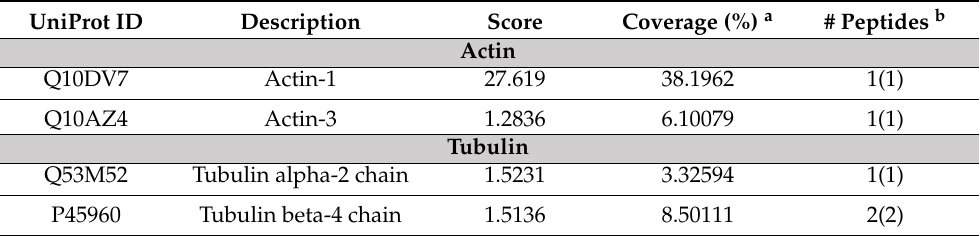
Table 4. Plastoskeletal proteins from microsieve-prepared starch granules (isopropanol